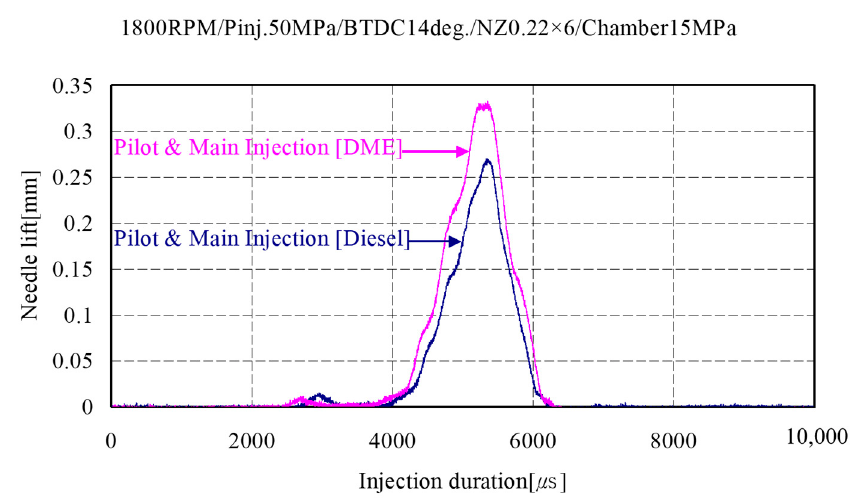
Figure 8. Injection line pressure between the common rail and the injector as a function of the following: with pilot injection of the injection duration for diesel and DME.